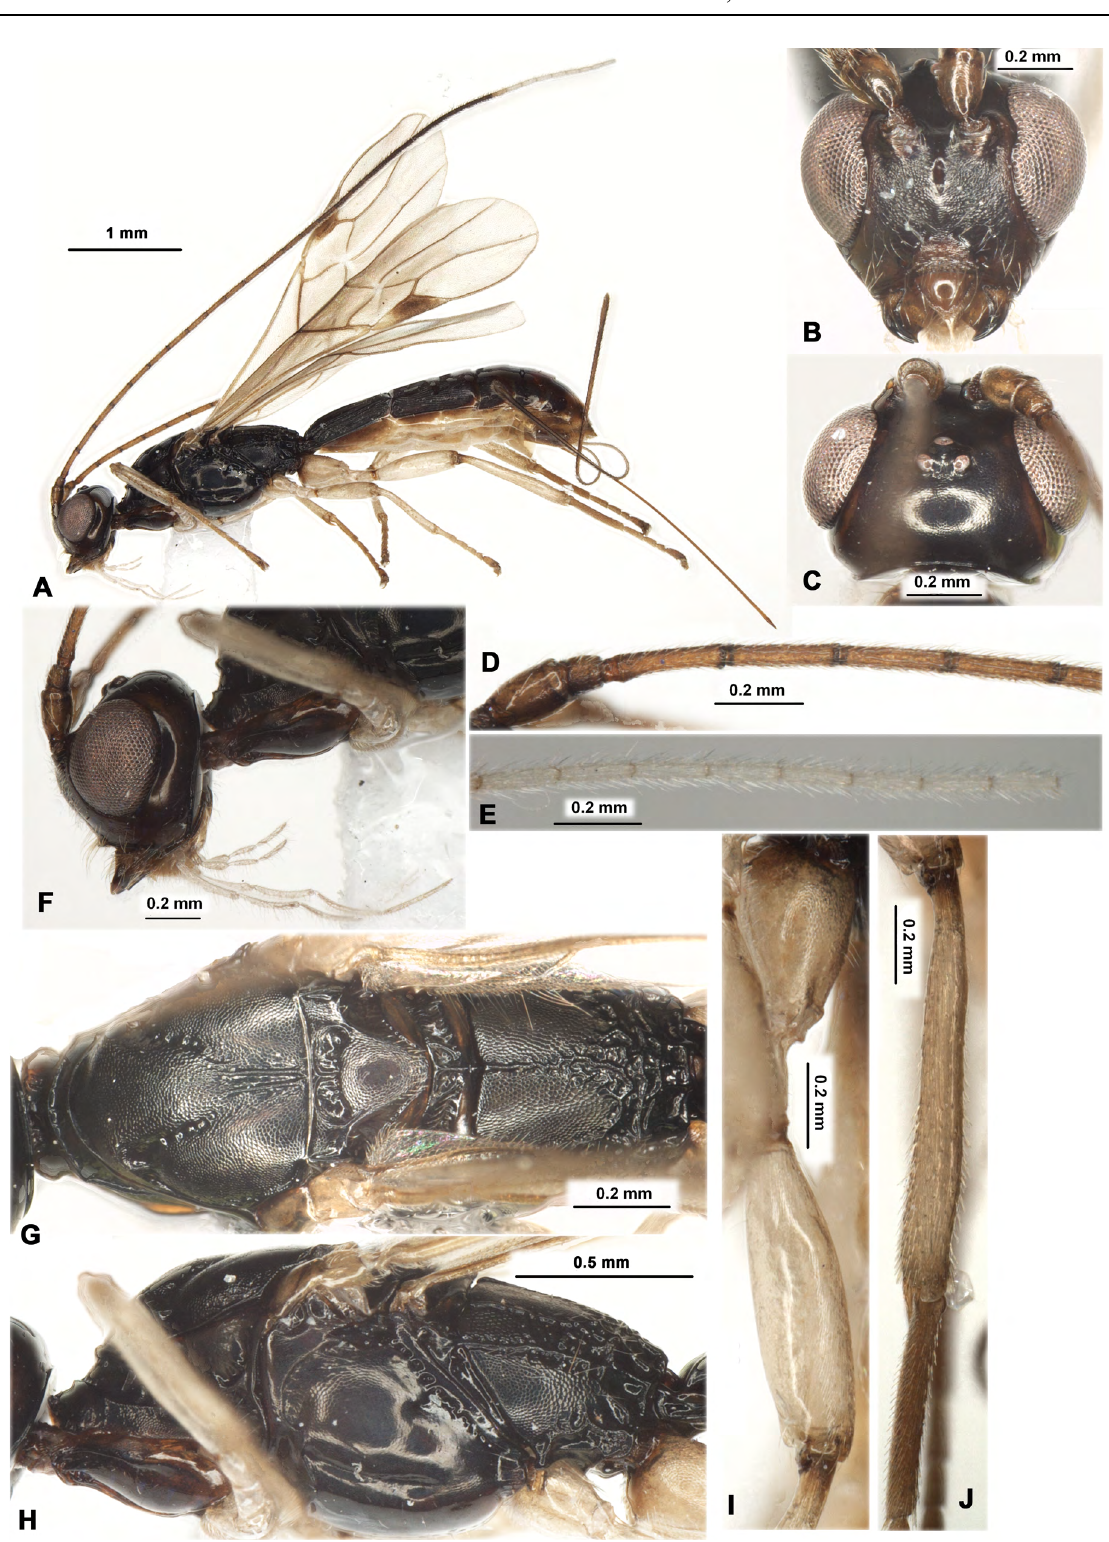
Fig. 56. Rhacontsira toamasina sp. nov., ♀, holotype, ZISP. A . Habitus, lateral view. B . Head, front view. C . Head, dorsal view. D . Basal segments of antenna. E . Apical segments of antenna. F . Head, lateral view. G . Mesosoma, dorsal view. H . Mesosoma, lateral view. I . Hind coxa and femur, lateral view. J . Hind tibia and basitarsus, lateral